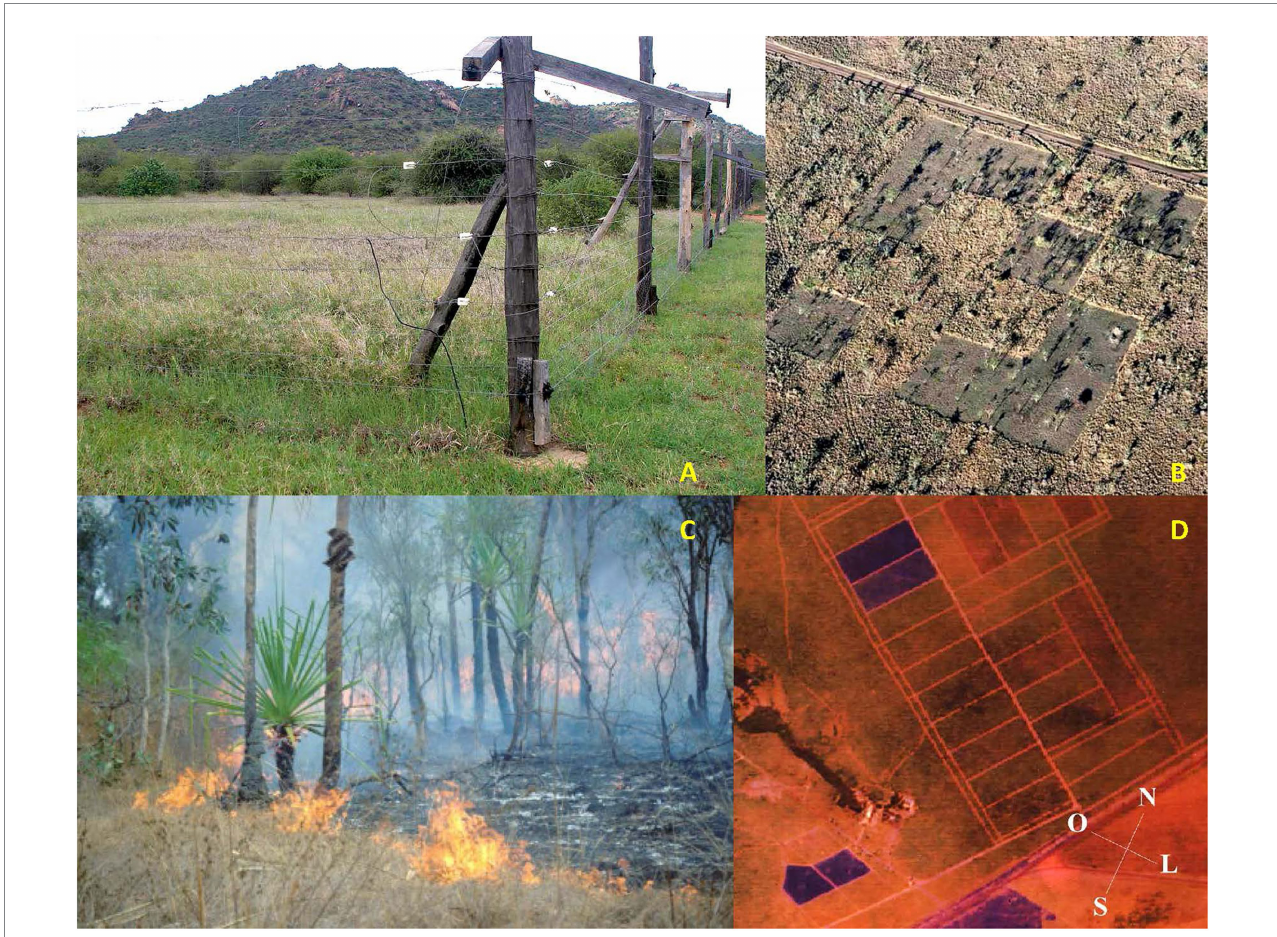
FIGURE 3 (A) Experimental LMH-exclusion plot on a glade (enriched soils of an abandoned cattle boma) on red sandy loam site at Mpala Research Center on the Laikipia Plateau of central Kenya. Electric fencing keeps LMH out but allows free passage of small rodents, shrews, and elephant shrews. Area outside the fence is an adjacent control plot. Overall abundance and diversity of small mammals was significantly greater inside exclosure than in the greener but shorter grazing lawn of the adjacent control (Bergstrom et al., 2018). Photo by BB. (B) Aerial photo of experimental “patchy” prescribed burn plot on whistling-thorn Acacia ( Acacia drepanolobium ) black cotton vertisol savanna habitat atop the escarpment at Mpala Research Center on the Laikipia Plateau of central Kenya. The 16-ha square area is divided into 1-ha pixels, nine of which have been burned, and seven unburned, and is surrounded by unburned matrix habitat. Small-mammal abundance was greater in unburned pixels, even 1–4 years after this photo was taken (Bergstrom et al., 2018). Photo courtesy of R. L. Sensenig. (C) Early-dry season wildfire on tropical savanna at Kapalga Research Station, Kakadu National Park, northern Australia (image taken by B. McKaige), which tends to be less severe and have less deleterious effects on small mammals than late-dry-season wildfire, from Griffiths and Brook (2015). (D) Aerial view of experimental plots of the “Fire Project” (Dias and Miranda, 2010), conducted between 1991 and 2011, in the Brazilian savanna (Cerrado). Rectangular areas in the image were 10-ha experimental plots covering typical Cerrado vegetation, burned with different fire frequencies (including every 2 years, every 4 years, and unburned control plots). Dark rectangles had just been burned when the image was taken (<1 month after burning). Two studies evaluated in the present review were conducted as part of the “Fire Project” (Vieira, 1999; Vieira and Briani,